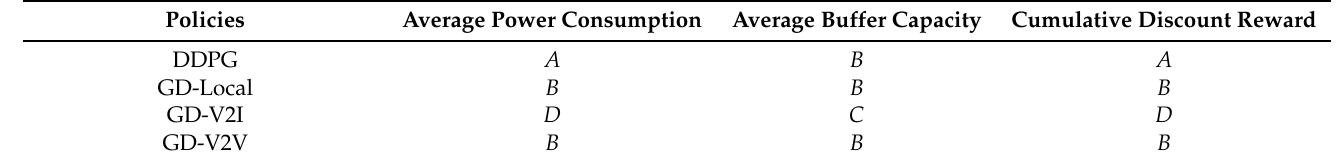
Table 3. Performance comparison under the four